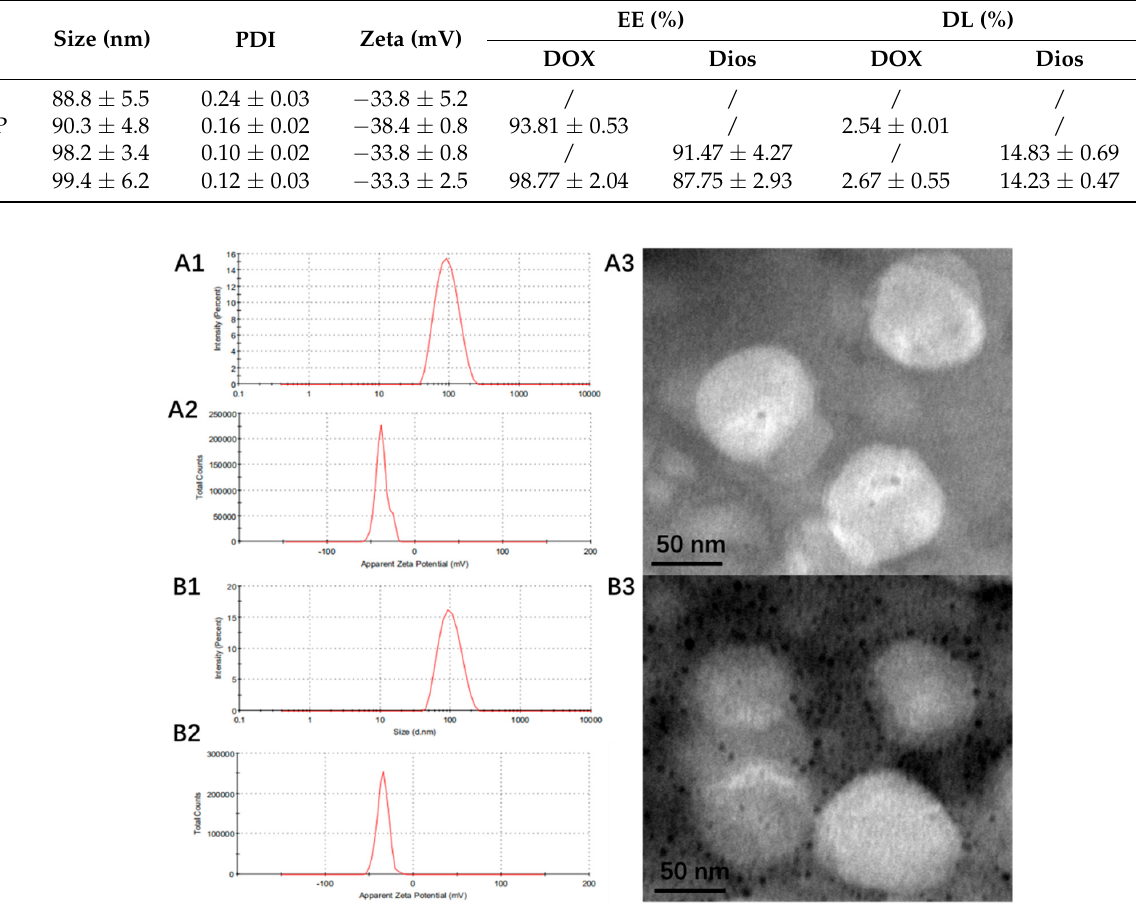
Table 1. Effects of DOX with different concentrations on particle size, potential and entrapment efficiency of liposomes of Dios-DOX-liposomes.